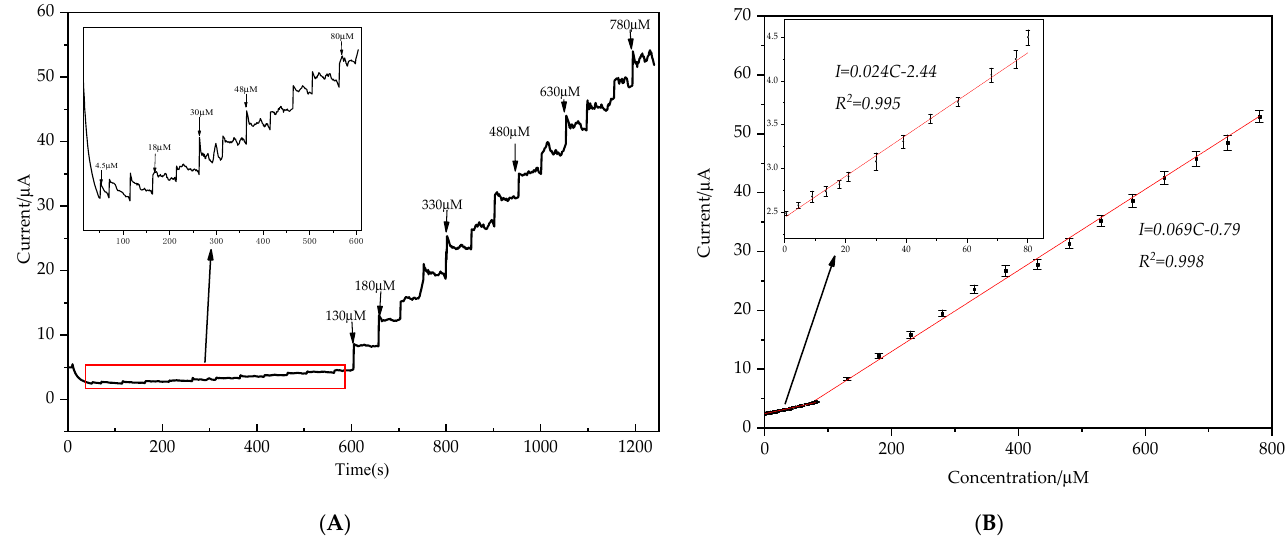
Figure 7. ( A ) Amperometric responses of AuNPs/MXene/ERGO/GCE in continuous add of NO2 − into 0.1 M PBS (pH 7) at an applied potential of 0.83 V (with stirred: 1200 r/min). Inset is the enlarge amperometric responses in a low concentration of nitrite. ( B ) Plot of relationship of current with nitrite concentration. Inset is the enlarge part of calibration plot. Table 1. Comparison of proposed sensor with another reported nitrite sensor.